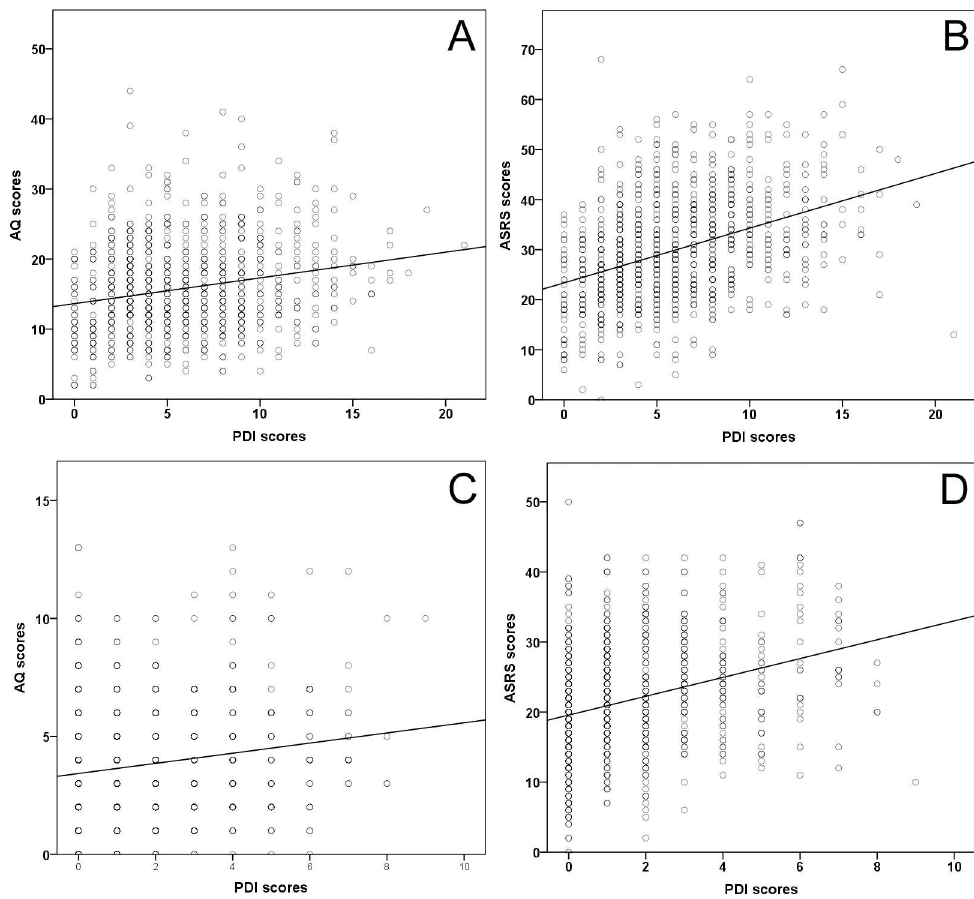
Fig 1. Correlations between PDI scores and AQ/ASRS scores on full and truncated versions of the questionnaires—two-tailed Spearman’s correlations— ** p < .001.A : Correlation betweenPDI scores and AQ scores (full questionnaires)—r = 0.192 ** . B : CorrelationbetweenPDI scores and ASRS scores (full questionnaires)—r = 0.406 ** . C : Correlation betweenPDI scores and AQ scores (truncated questionnaires)— r = 0.129 ** . D : CorrelationbetweenPDI scores and ASRS scores (truncated questionnaires)—r = 0.324 ** .